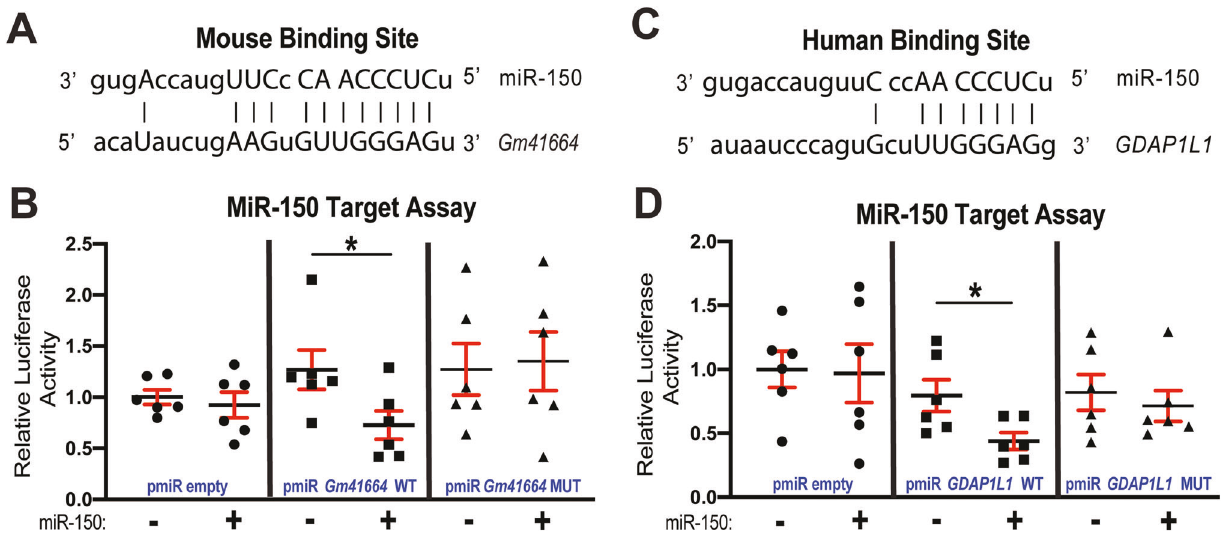
Fig. 6 MiR-150 interacts with Gm41664 and GDAP1L1 . A Mouse Gm41664 has the strongest miR-150 binding site with 12-mer complementary sequences. MiR-150 seed pairing in the target region and complementary sequences outside the seed region are presented as vertical lines. B MiR-150 ’ s capability of directly repressing the activity of luciferase (LUC) reporter constructs that include either wild-type (WT) or mutated (MUT) binding sites for Gm41664 . Transfection with or without miR-150 mimic in H9c2 cells is shown as + or − . The LUC activity of Fire fl y was normalized to the LUC activity of Renilla and compared with empty vector measurements. N = 6. Unpaired two-tailed t - test. C Human GDAP1L1 has a conserved miR-150 binding site in the 3 ’ -untranslated region (3 ’ UTR). MiR-150 seed pairing in the target region and complementary sequences outside the seed region are presented as vertical lines. D The direct ability of miR-150 to inhibit the activity of LUC reporter constructs that include either WT or MUT binding sites for GDAP1L1 . Transfection with or without miR-150 mimic in AC16 cells is indicated as + or − . The LUC activity of Fire fl y was normalized to the LUC activity of Renilla and compared to empty vector measurements. N = 6. Unpaired two-tailed t -test. * P < 0.05 vs. miR mimic focus on the other 20 potentially bene fi cial genes (Table S5: see green-shaded columns) is that they are downregulated in ISO GRK – β